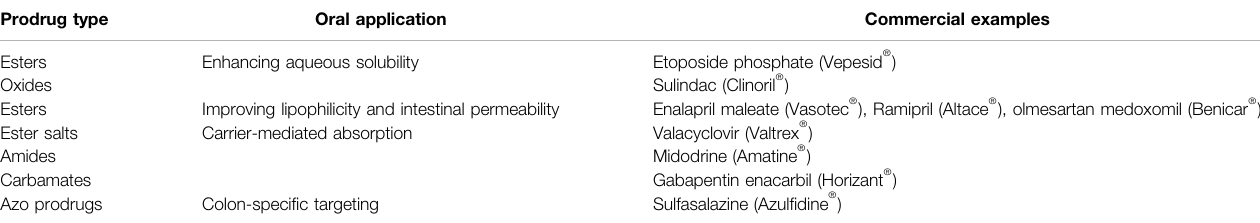
TABLE 6 | Representative examples of prodrugs used for oral drug